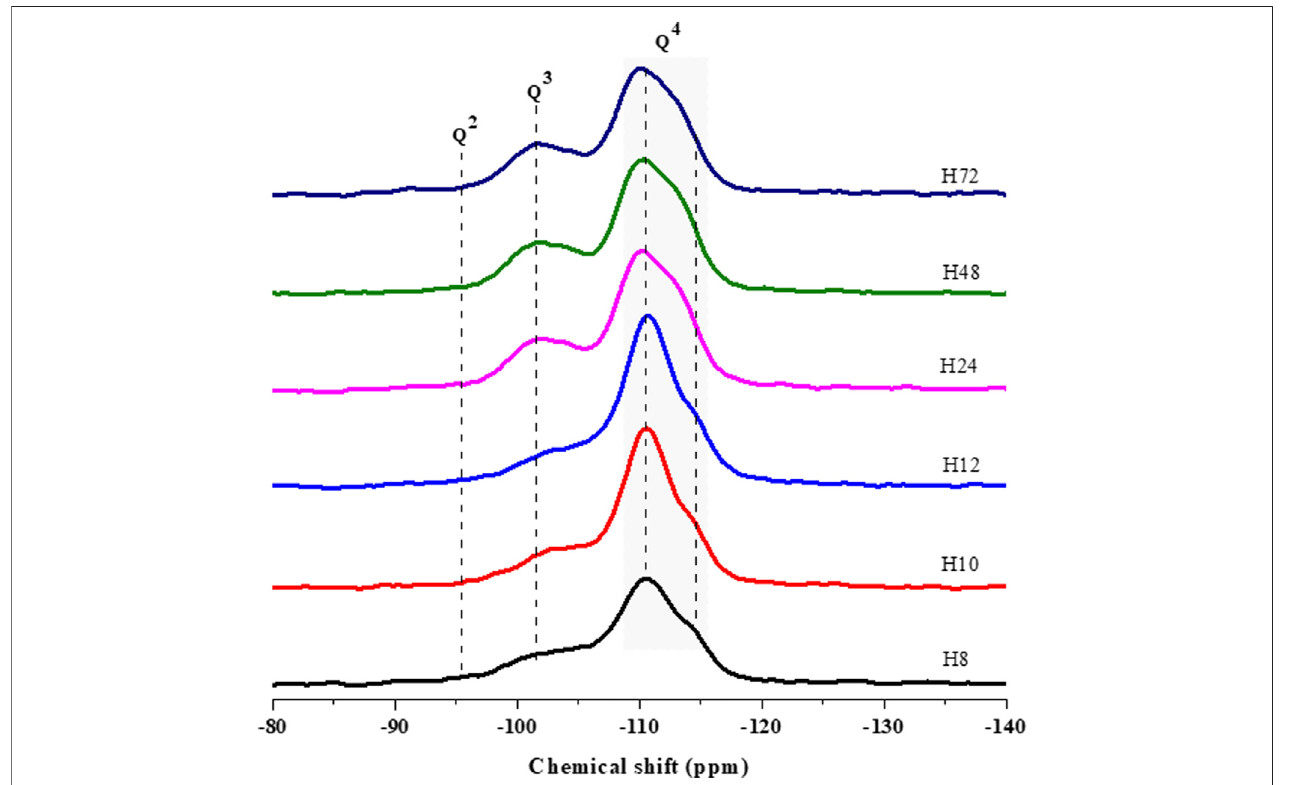
FIGURE 7 | 29 Si MAS NMR spectra of HBEA zeolites produced from CFA nanosilica extract at different hydrothermal times.